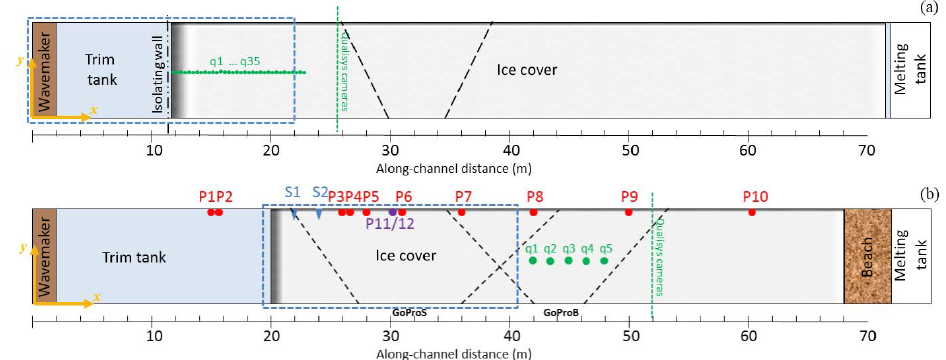
Figure 1. Instrument setup during test group A (a) and B (b) : single pressure sensors are marked in red, a double pressure sensor in violet, ultrasound sensors in blue, and Qualisys markers in green; dashed black lines show fields of view of sideward-looking GoPro cameras (GoProS and GoProB for Silver and Black models, respectively), and dashed blue lines show fields of view of the cameras mounted on the